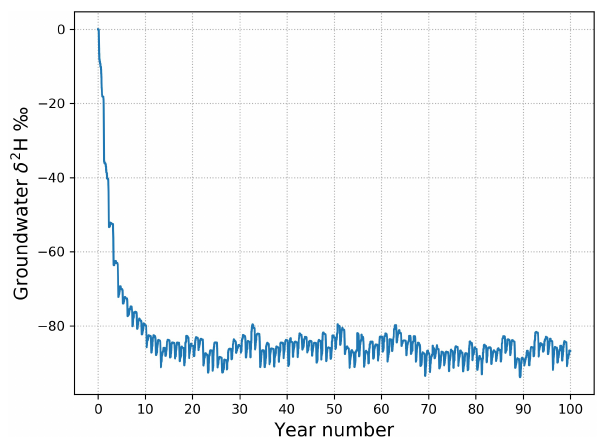
Figure 4. Evolution of the modeled isotopic ratio in groundwater over a 100-year period with R r = 0 . 3 and R s = 0 . 6.